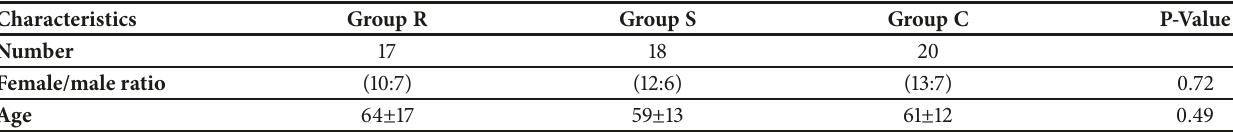
Table 8: Demographic characteristics at baseline of 55